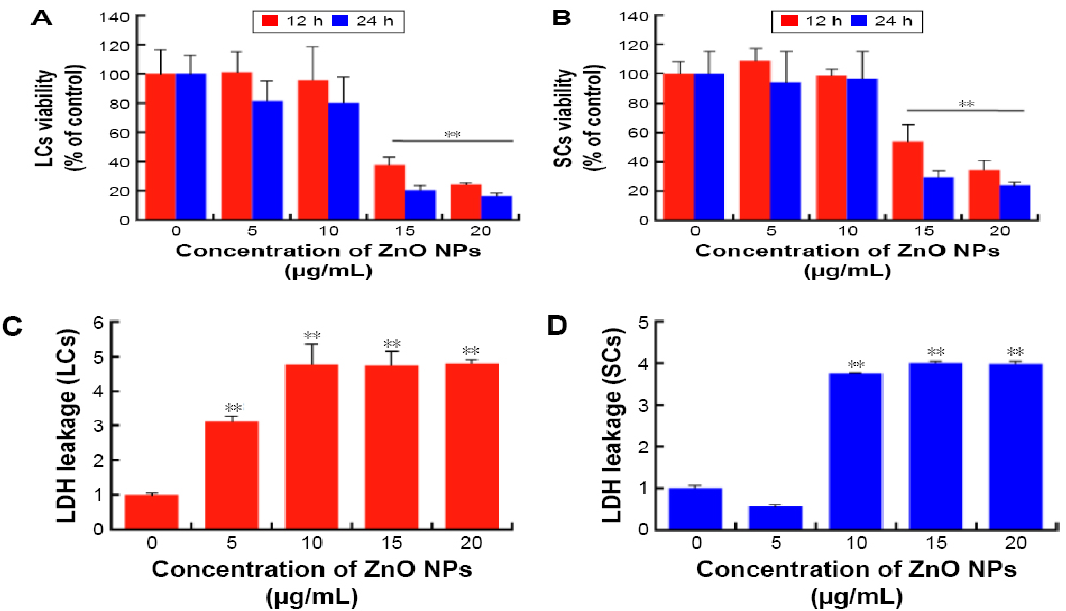
Figure 22. Transmission electron microscopic images showing ( a ) untreated Leydic cell (control), and ( b – d ) localization of ZnO NPs within the nucleus (N) and cytoplasm (Cy) of the cell. Bottom panel: high magnification views of the framed region. Reproduced from [143] with under the Creative Commons Attribution—Non Commercial (unported, v3.0) license.